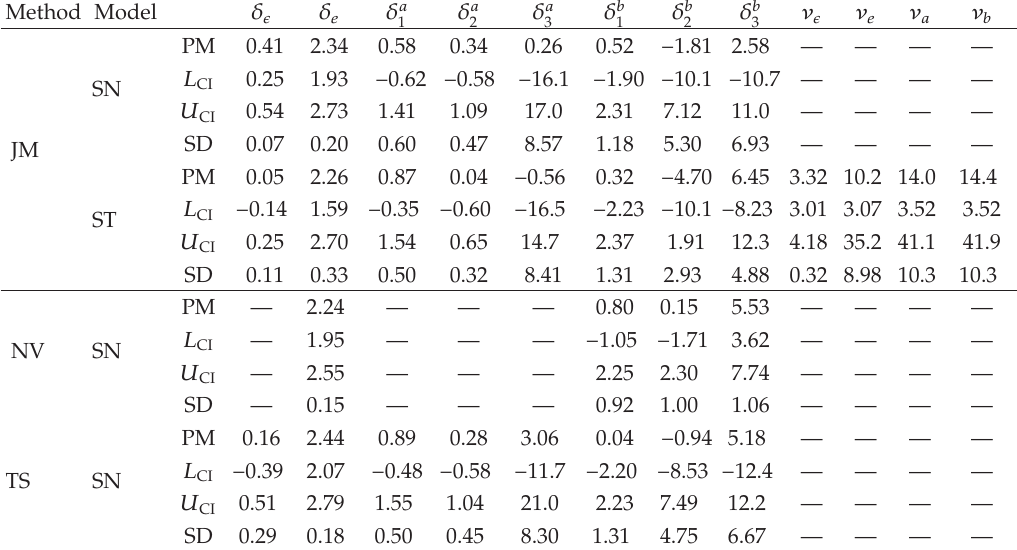
Table 2: A summary of the estimated posterior mean (cid:3) PM (cid:4) of skewness and degree of freedom parameters, the corresponding standard deviation (cid:3) SD (cid:4) , and lower limit (cid:3) L CI (cid:4) and upper limit (cid:3) U CI (cid:4) of 95% equal-tail credible interval (cid:3) CI (cid:4) based on the joint modeling (cid:3) JM (cid:4) , the naive (cid:3) NV (cid:4) , and the two-step (cid:3) TS (cid:4) methods. Method